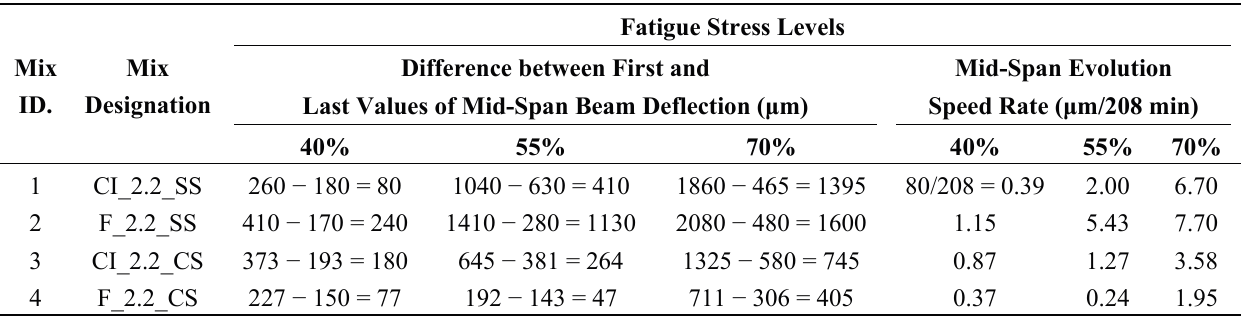
Table 6. Speed rate of mid-span deflection evolution at different fatigue stress levels.